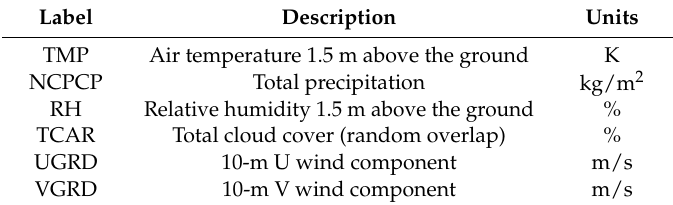
Figure 3. Model computation area. ( a ) South Korea; ( b ) air temperature forecast for the Seoul metropolitan area 1.5 m above the ground. Table 1. Local Data Assimilation and Prediction System (LDAPS) variables used for downscaling of air temperature.